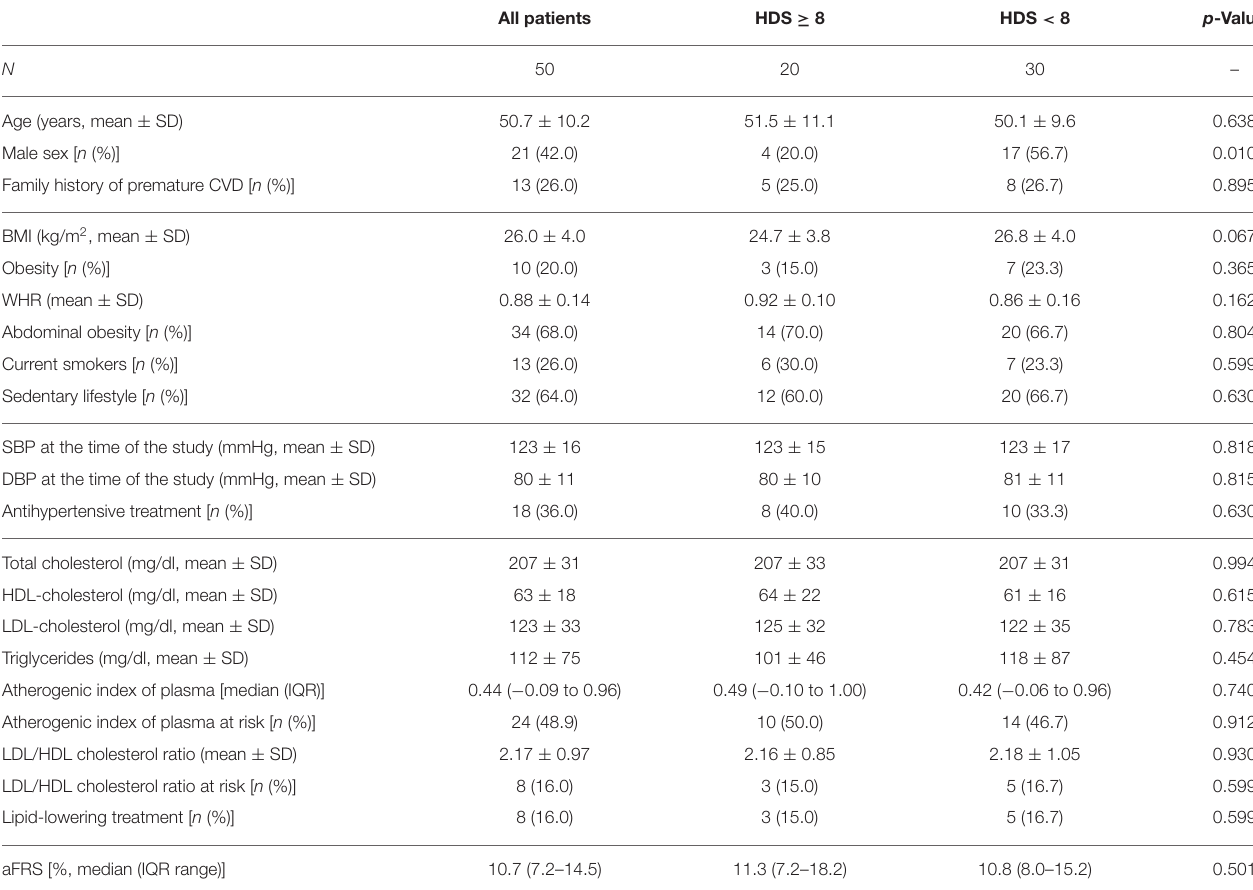
TABLE 2 | Traditional risk factors for cardiovascular disease.